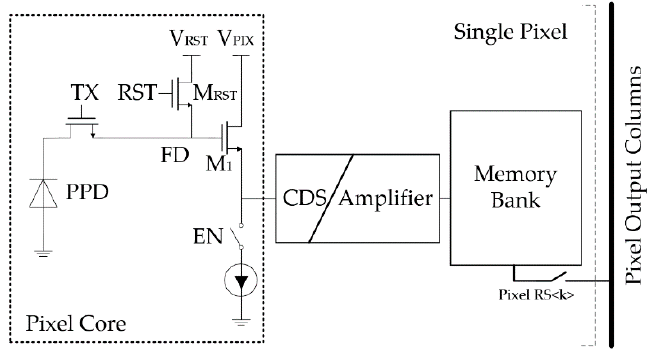
Figure 1. The proposed pixel architecture for burst mode imagers.